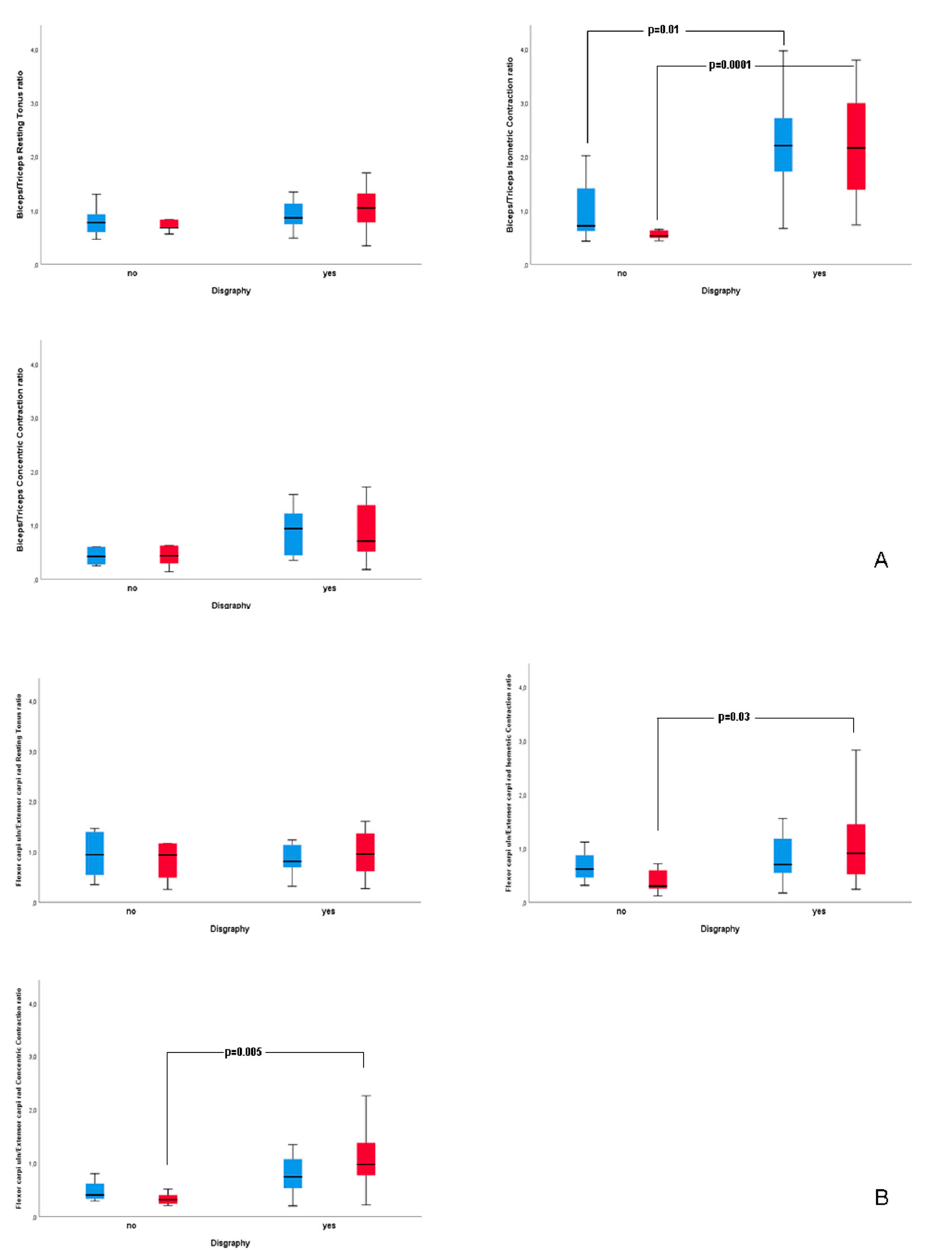
Figure 3. Flexors / Extensors (Biceps / Triceps, panel A and Flexor carpi ulnaris / Extensor carpi radialis, panel B ) ratios for main sEMG parameters measured for dominant (red bars) and non-dominant (blue bars) upper limb in dysgraphic and non-dysgraphic patients enrolled in the study.